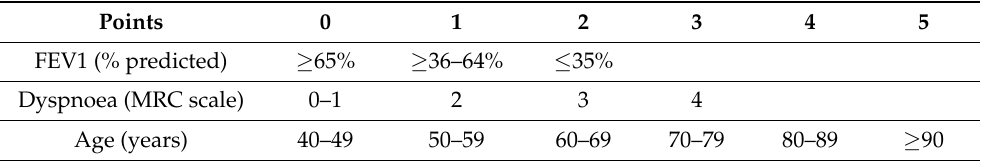
Table 1. Assignment of points for the age, dyspnoea, airflow obstruction (ADO) index. Points